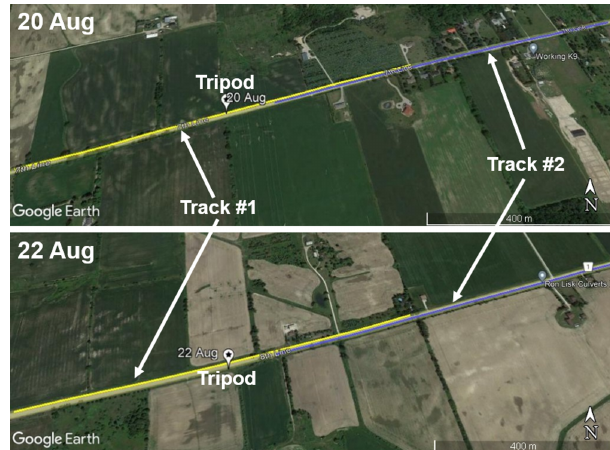
Figure 2. The measurement site on 20 August (top) and 22 August (bottom), with the 1000m tracks driven by the car superimposed. Track #1 is shown as a yellow line, and Track #2 is shown as a blue line. Track #1 is centered on the location of the tripod; therefore, 500m of highway are included in Track #1 on either side of the tripod location. Track #2 begins 120m away from the tripod; there- fore, it does not include any measurements made on the highway directly in front of the tripod. © Google Earth